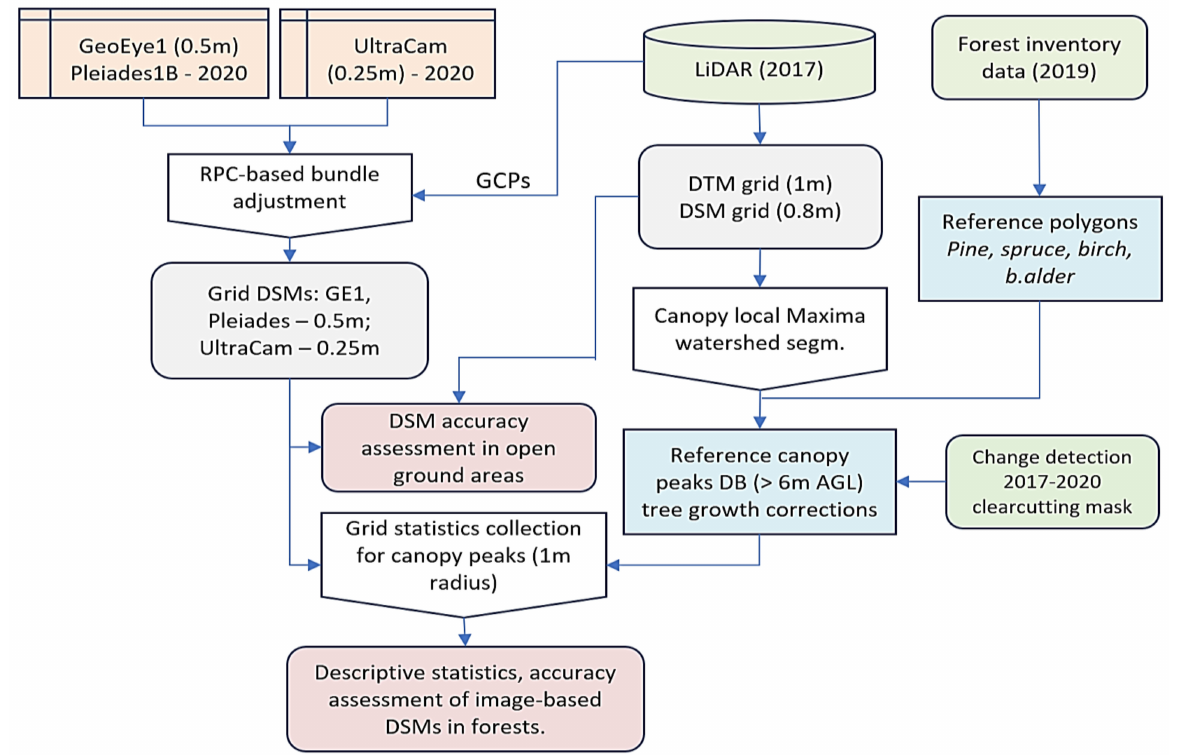
Figure 3. Workflow overview of a given